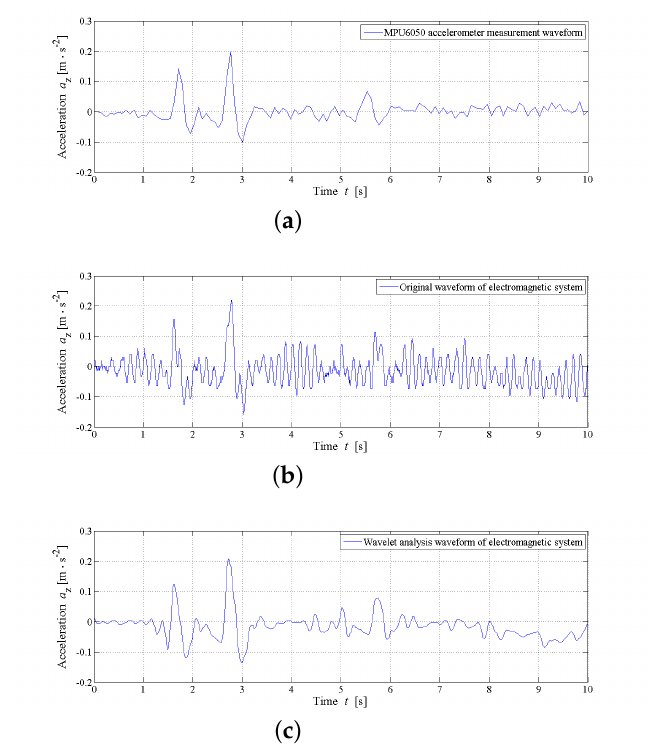
Figure 8. Z -direction acceleration measurement waveform: ( a ) MPU6050 accelerometer measurement waveform; ( b ) original waveform of electromagnetic suspension system; ( c ) wavelet analysis waveform of electromagnetic system.